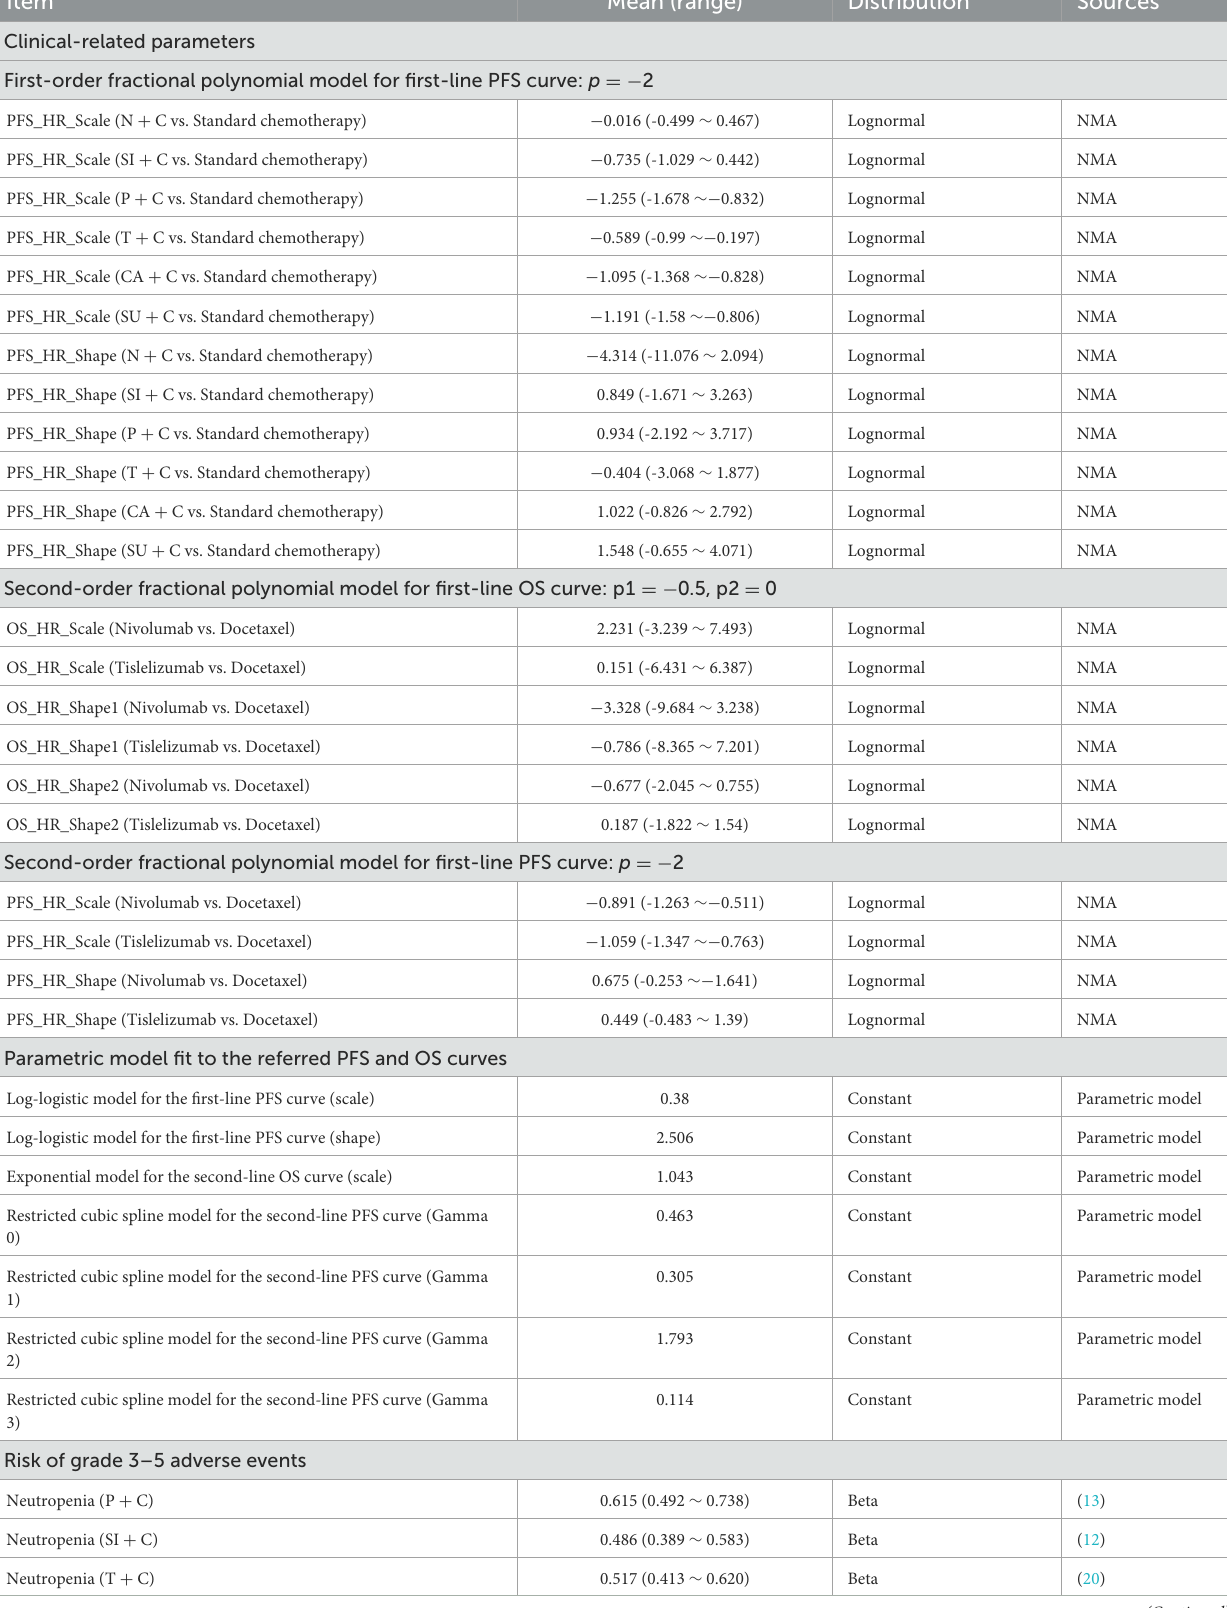
TABLE 1 Parameters used in the